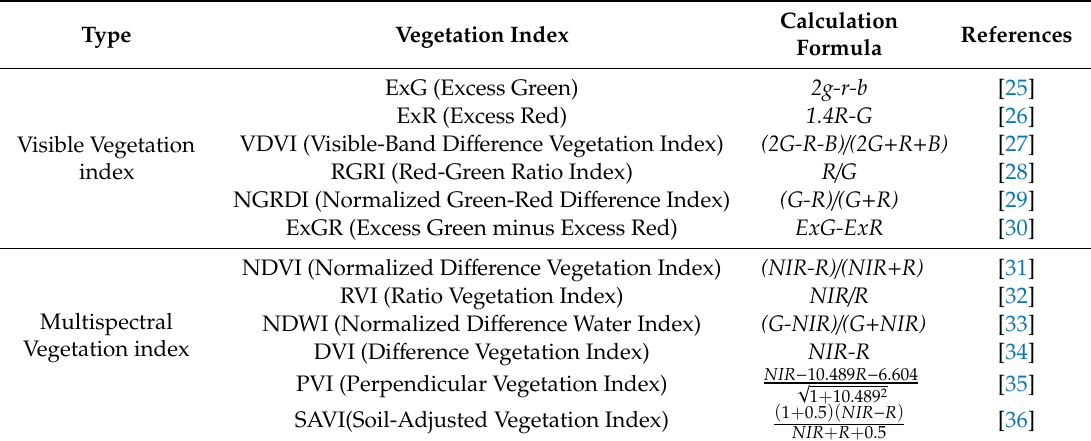
Table 1. Vegetation Index